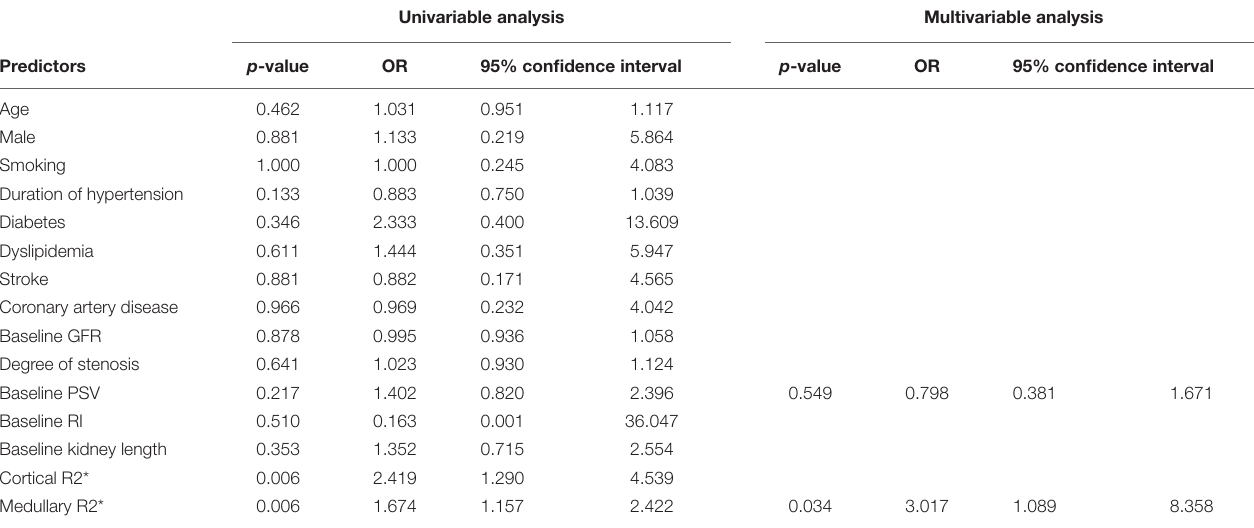
TABLE 5 | Univariable and Multivariable predictors of split renal function improvement after renal artery